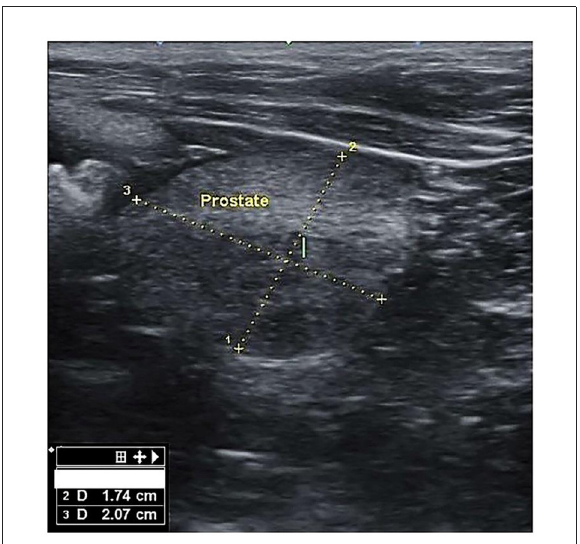
FIGURE1 Transverse section of the prostate gland in dogs suffering from BPH, showing the height (1) and width